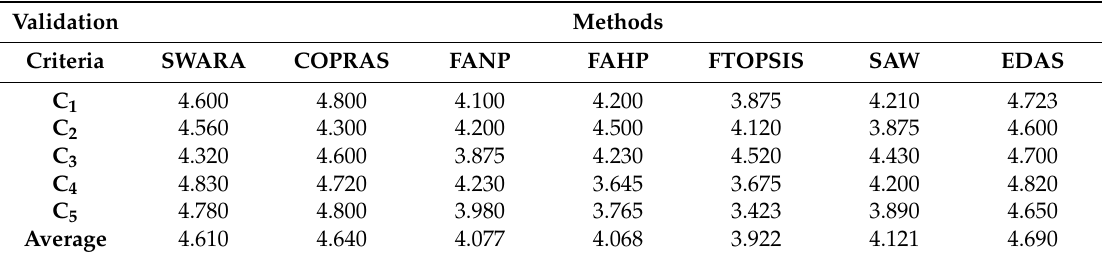
Table 9. Results of the validation exercise for the risk prioritization